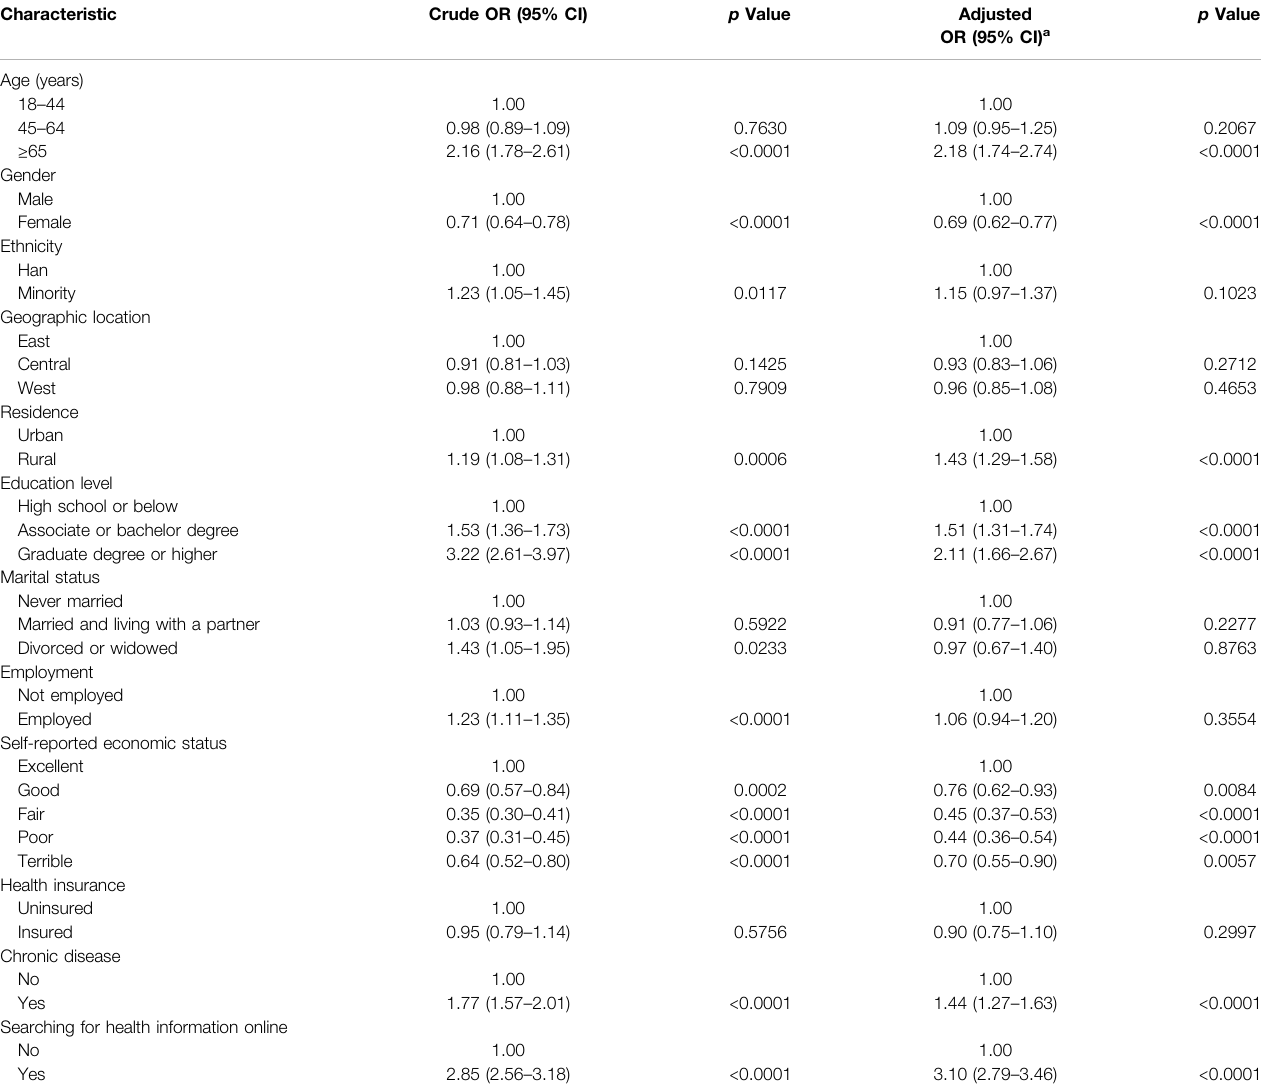
TABLE 2 | Univariable and multivariable logistic regression of factors associated with antibiotic purchase online in the past 3 months.